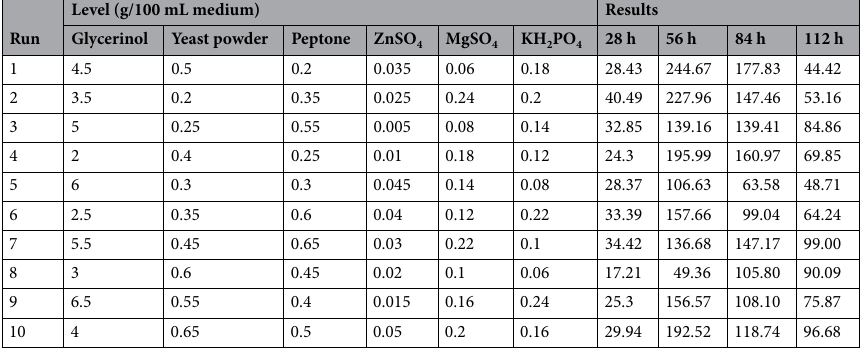
Table 1. The scheme and running results of U 10 (10 6 ) uniform-design (μg/L).